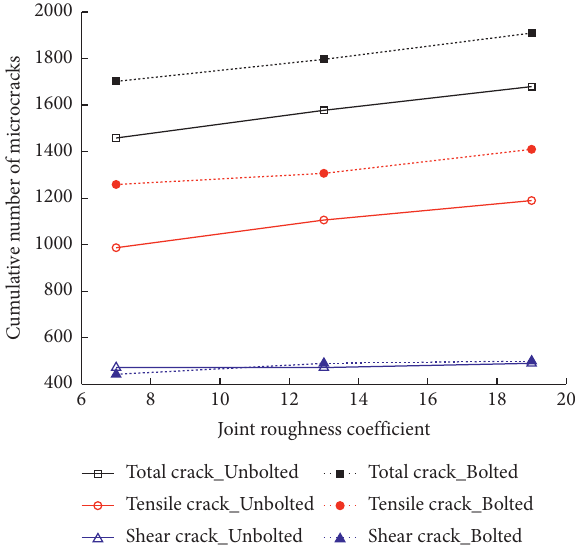
Figure 14: Relationship between JRC and